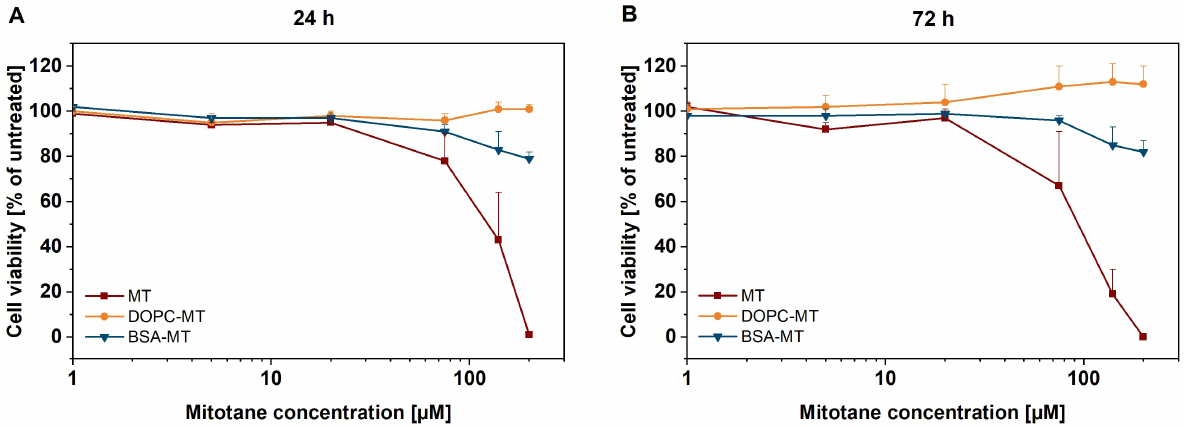
Figure 9. Representation of 2D cell culture: in vitro cytotoxicity of albumin-stabilized mitotane (BSA-MT), liposomal mitotane (DOPC-MT), and free mitotane (MT). Cell viability of GM00038 human dermal fibroblasts in a 2D monolayer model was analyzed using the CellTiter-Glo ® cell viability assay ( A ) 24 h and ( B ) 72 h after sample treatment. Data are expressed as mean ± SD, n = 3.